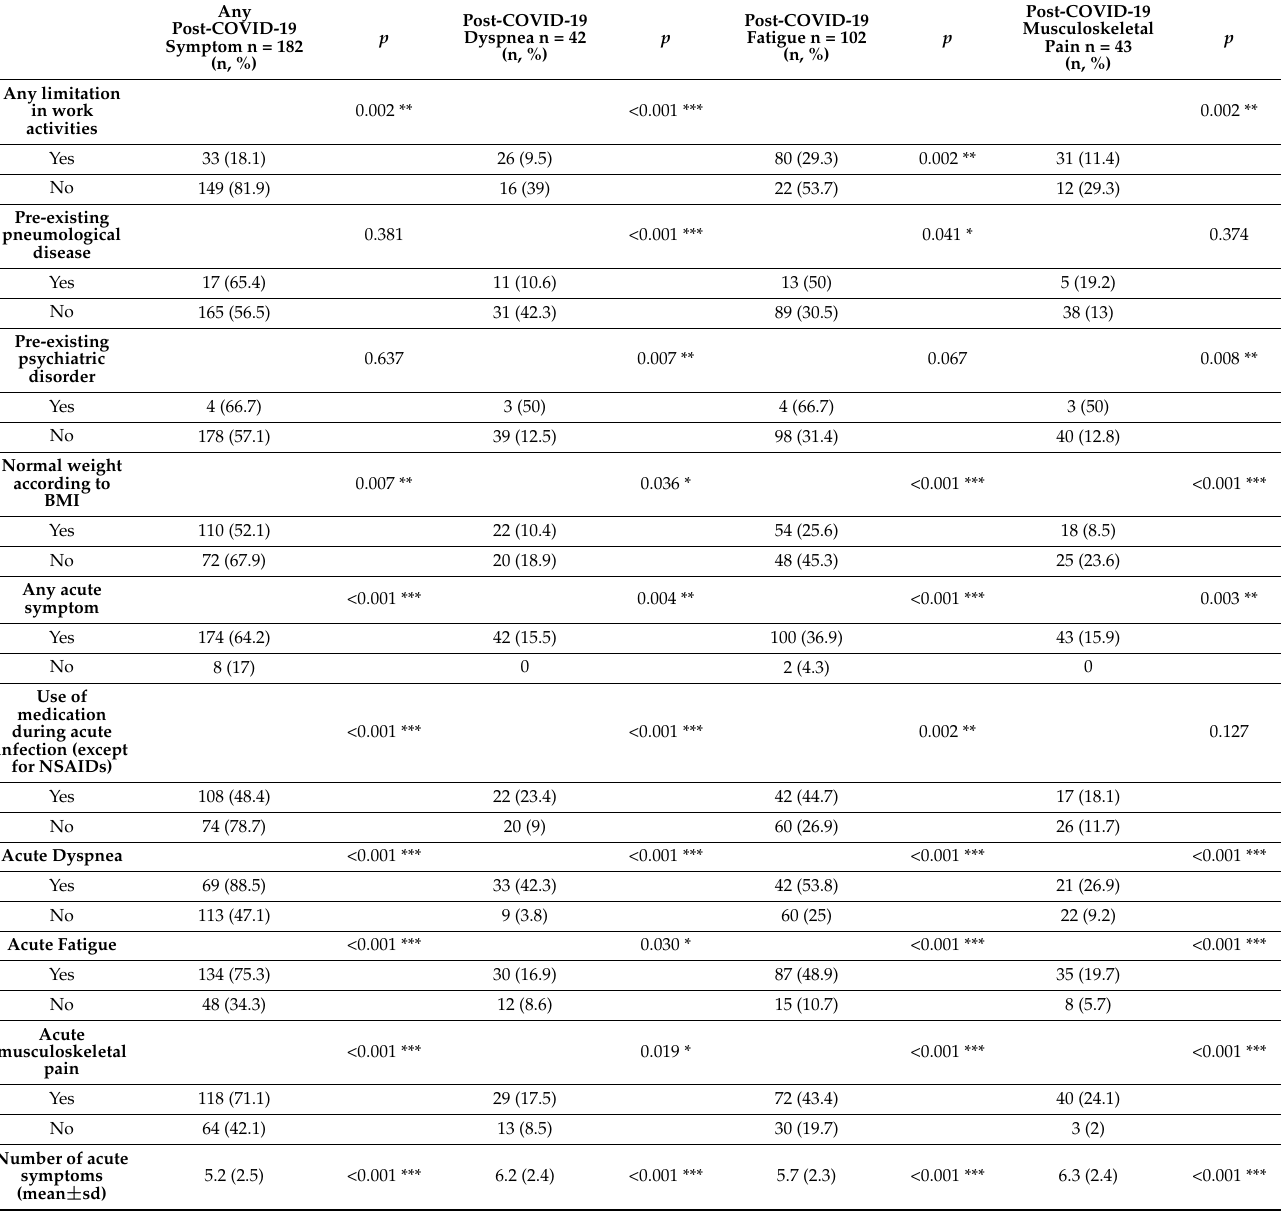
Table 2. Correlations between any post-COVID-19 symptom, post-COVID-19 dyspnea, post-COVID- 19 fatigue, post-COVID-19 musculoskeletal pain, and baseline and acute disease characteristics of the